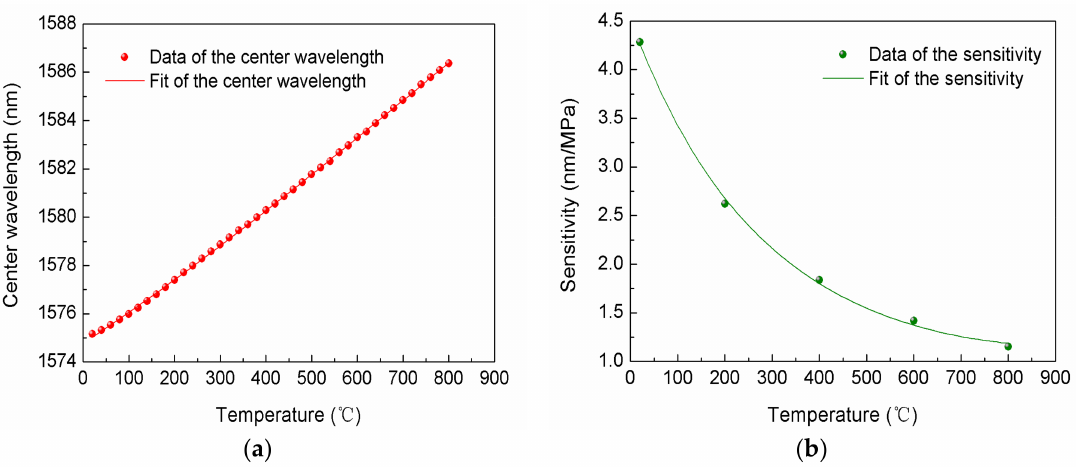
Figure 9. Fitting curves of the relationship of: ( a ) FBG center wavelength and temperature; ( b ) sensitivity and